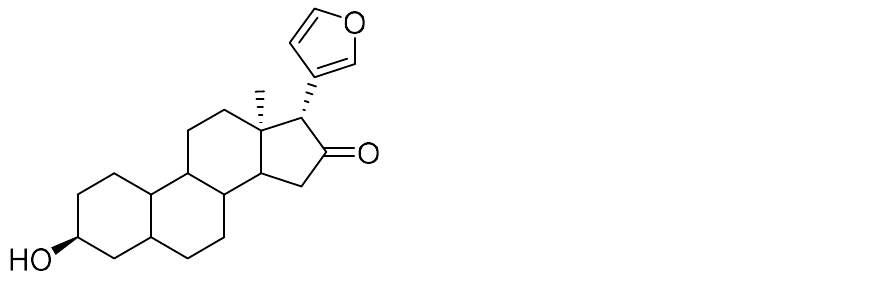
capacity against different stages of S. frugiperda , presenting antifeedant and repellent ac-